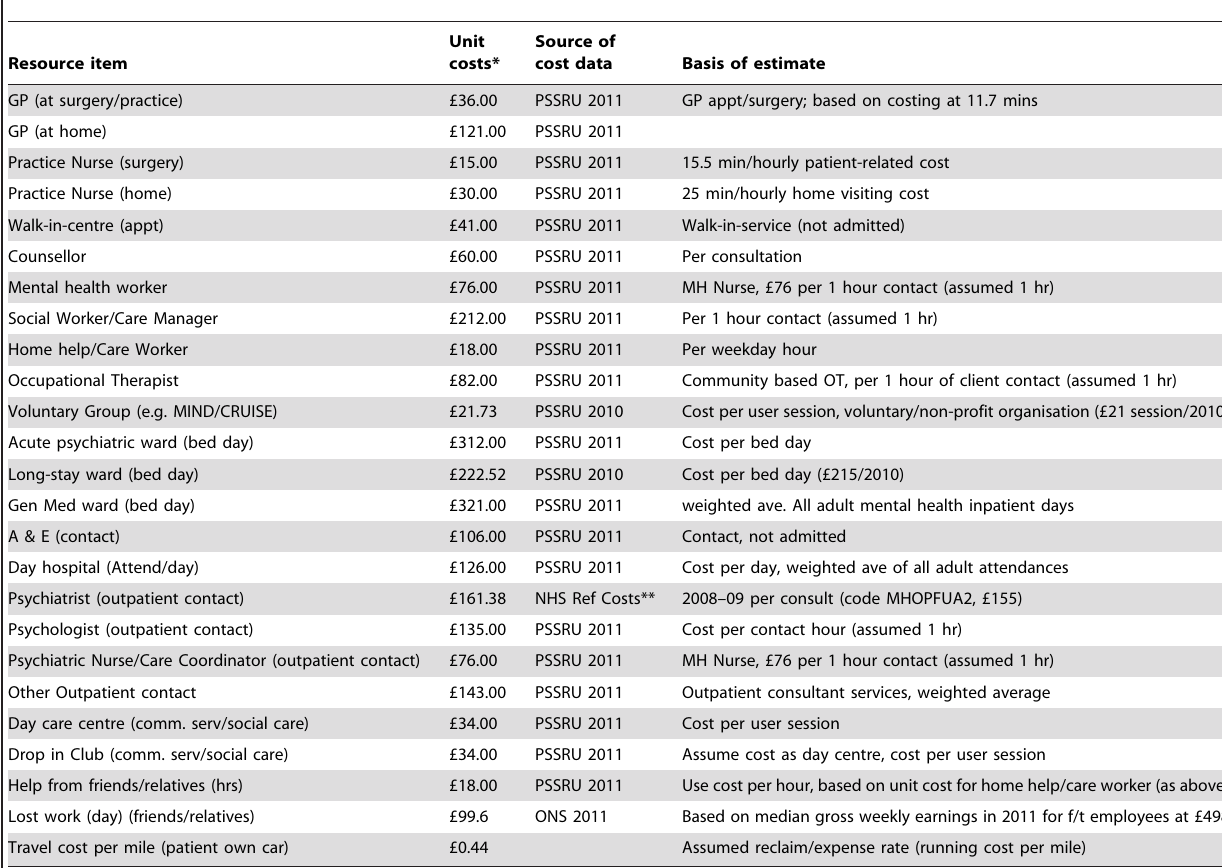
Table 1. Unit costs for different types of health and social care resource